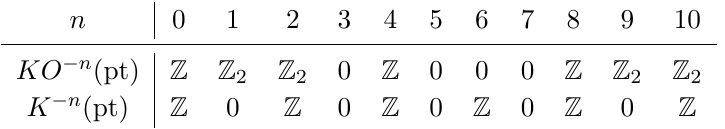
Table 2 . K- and KO-groups of the point up to n = 10